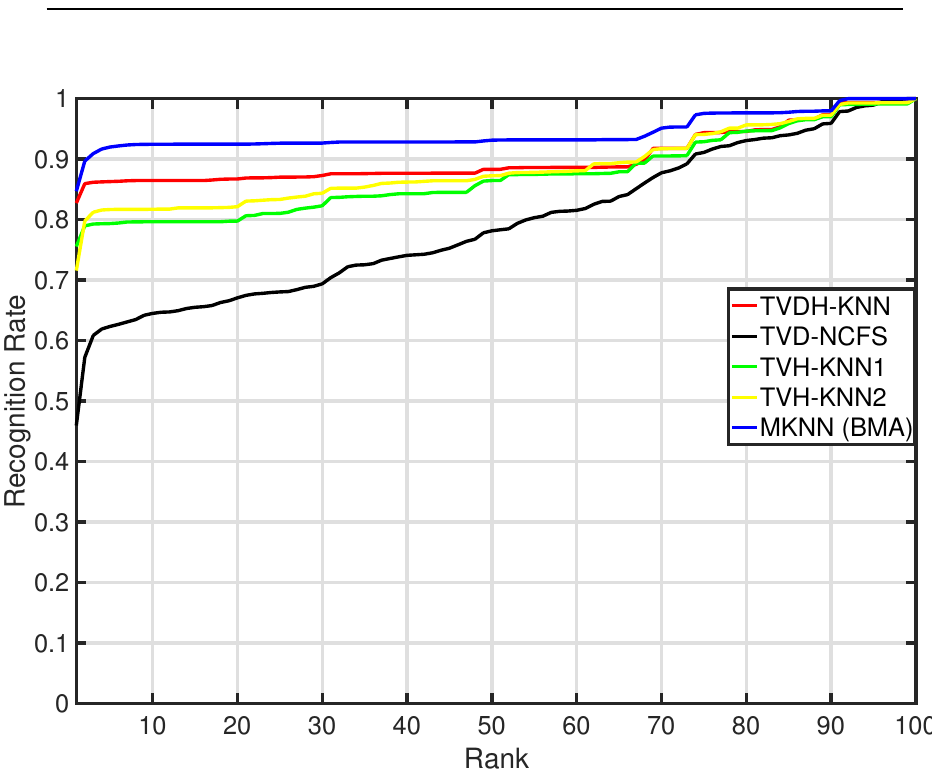
Figure 6. The CMC curves of the MKNN and the standard K-NN